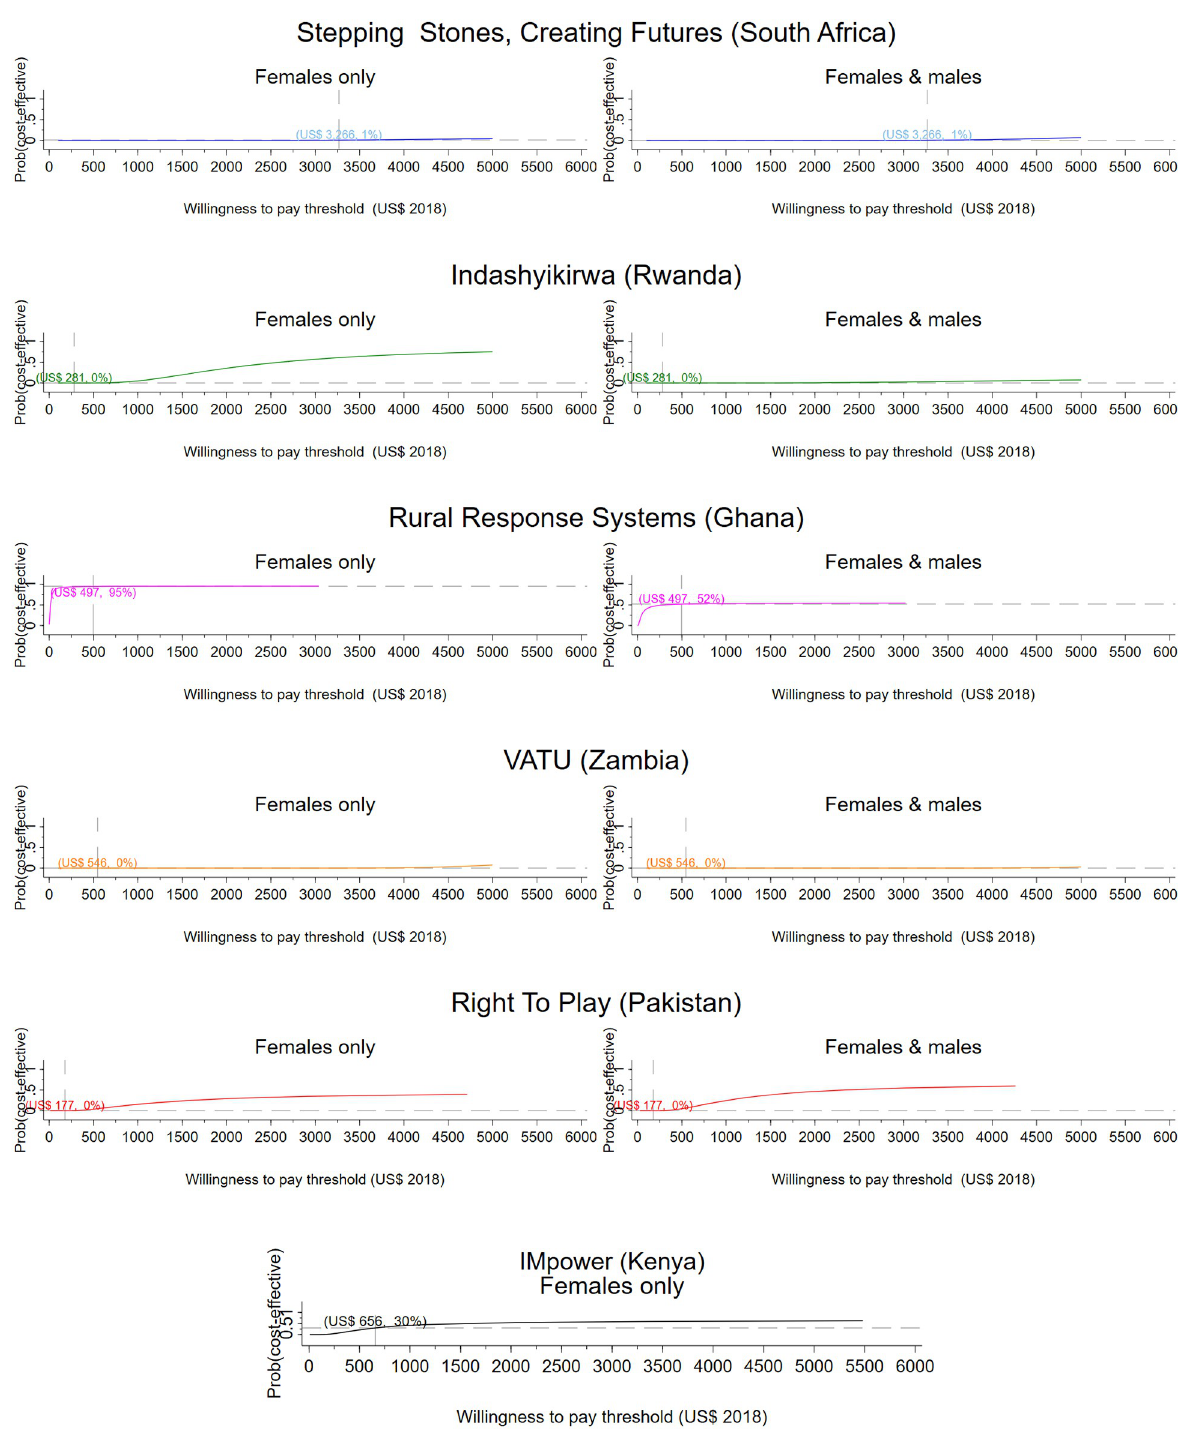
Fig 1. Research setting, provider perspective. CEACs illustrating the probability that the intervention is effective for a range of thresholds. Dashed vertical line: country-specific opportunity cost threshold; dashed horizontal line: probability that the intervention is cost-effective at the country- specific threshold, given the cost per DALY averted by the intervention. CEAC, cost-effectiveness acceptability curve; DALY, disability-adjusted life year; VATU, Violence and Alcohol Treatment.